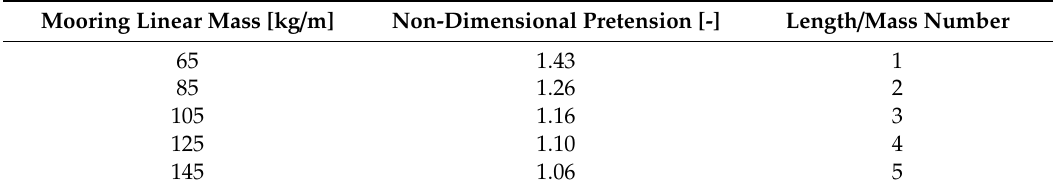
from combining each linear mass with each non-dimensional